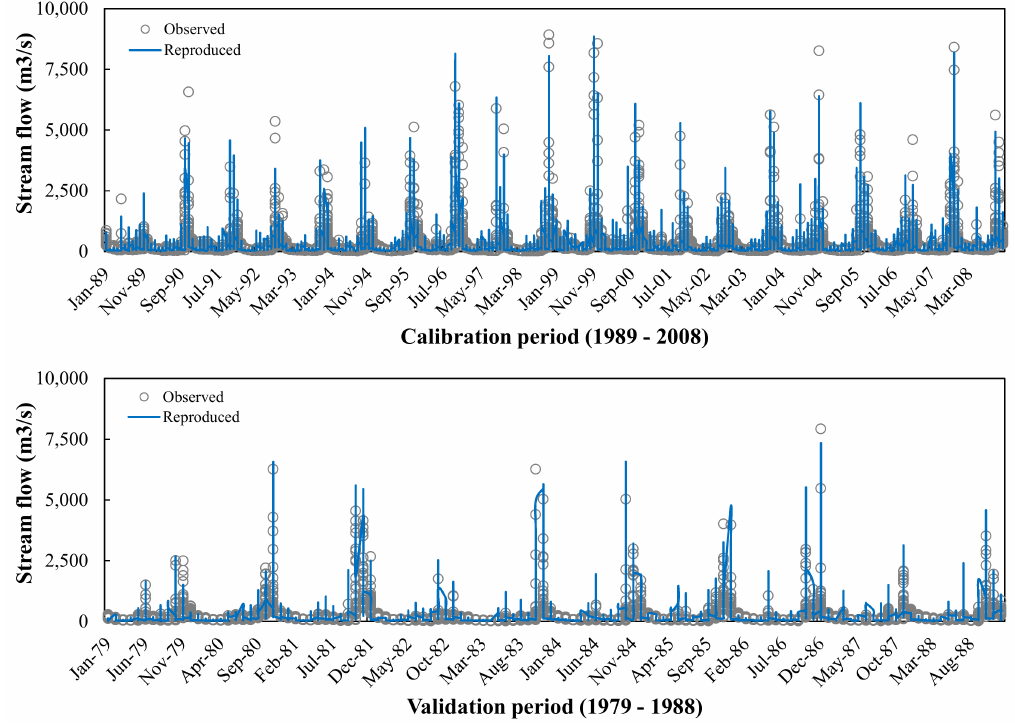
Figure 4. Time series of the daily observed and reproduced streamflow for the upper Thu Bon River basin at Nong Son: ( Upper ) calibration period (1989–2008) and ( Lower ) validation period (1979–1988).